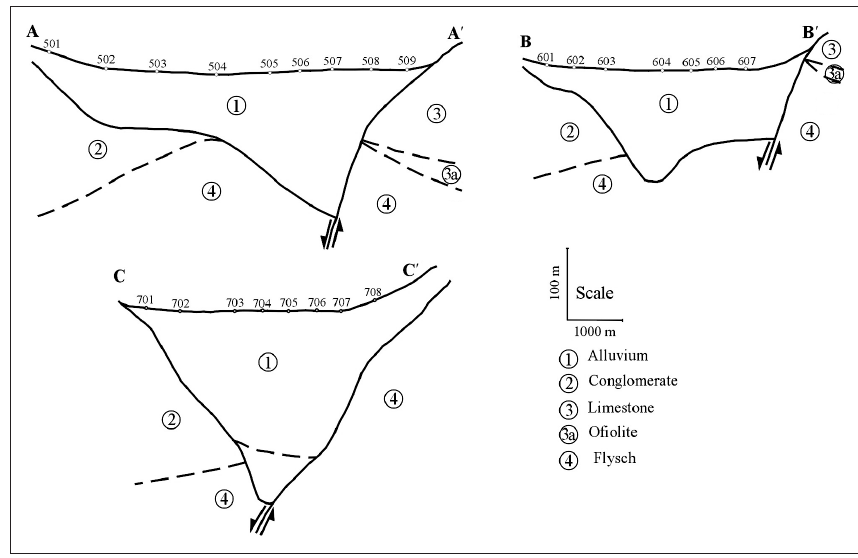
Fig. 3. E-W cross-sections across the Dinar Graben determined from the resistivity tests shown in fig. 2 (after Ozpinar, 1978; Turker et al ., 1996; Kayabali,